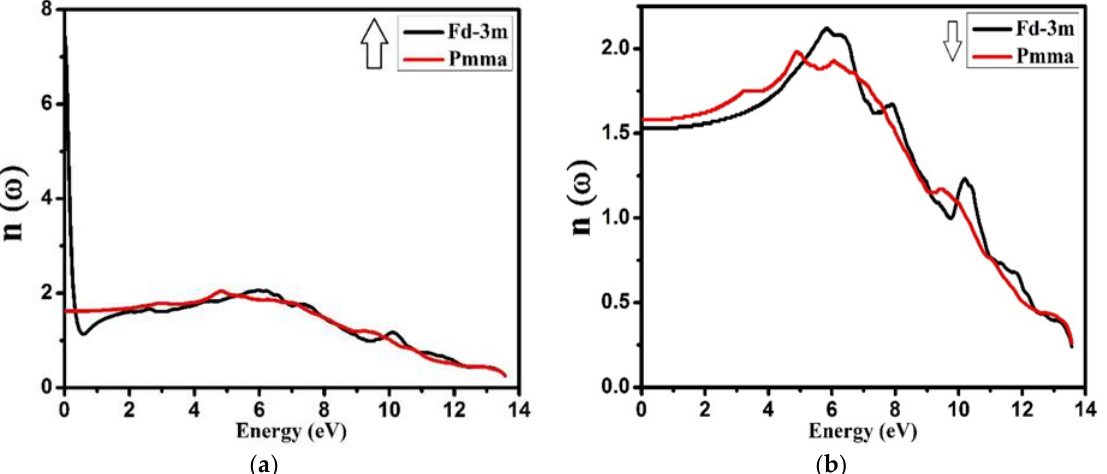
Figure 12. Calculated refractive index n (ω) for Nd 2 Zr 2 O 7 ((black color for Fd-3m) and (red color for Pmma)) using GGA+U. ( a ) The spin-up direction ( ↑ ) and ( b ) spin-down ( ↓ ) direction.